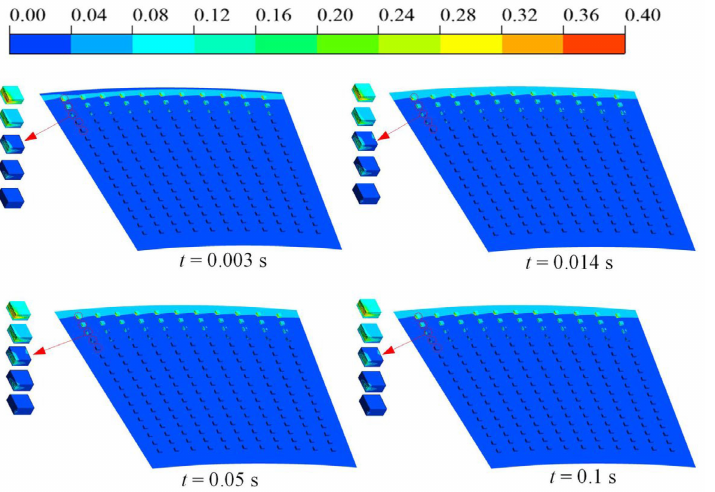
Figure 19. Cavitation morphology change with hexahedral texture rate 6.41%.